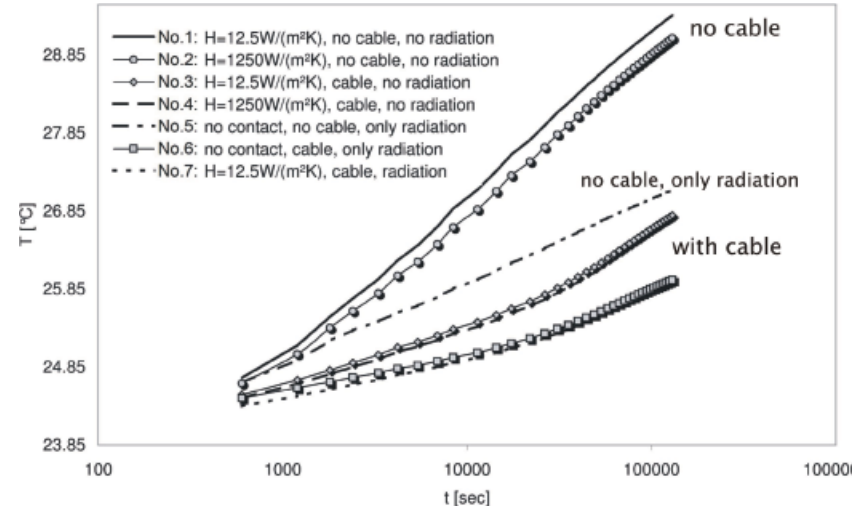
Fig. 9. Temperature response of the commercial TP02-sensor at the measurement point due to heating in a very low conductivity sample with λ = 0 . 002Wm − 1 K − 1 .